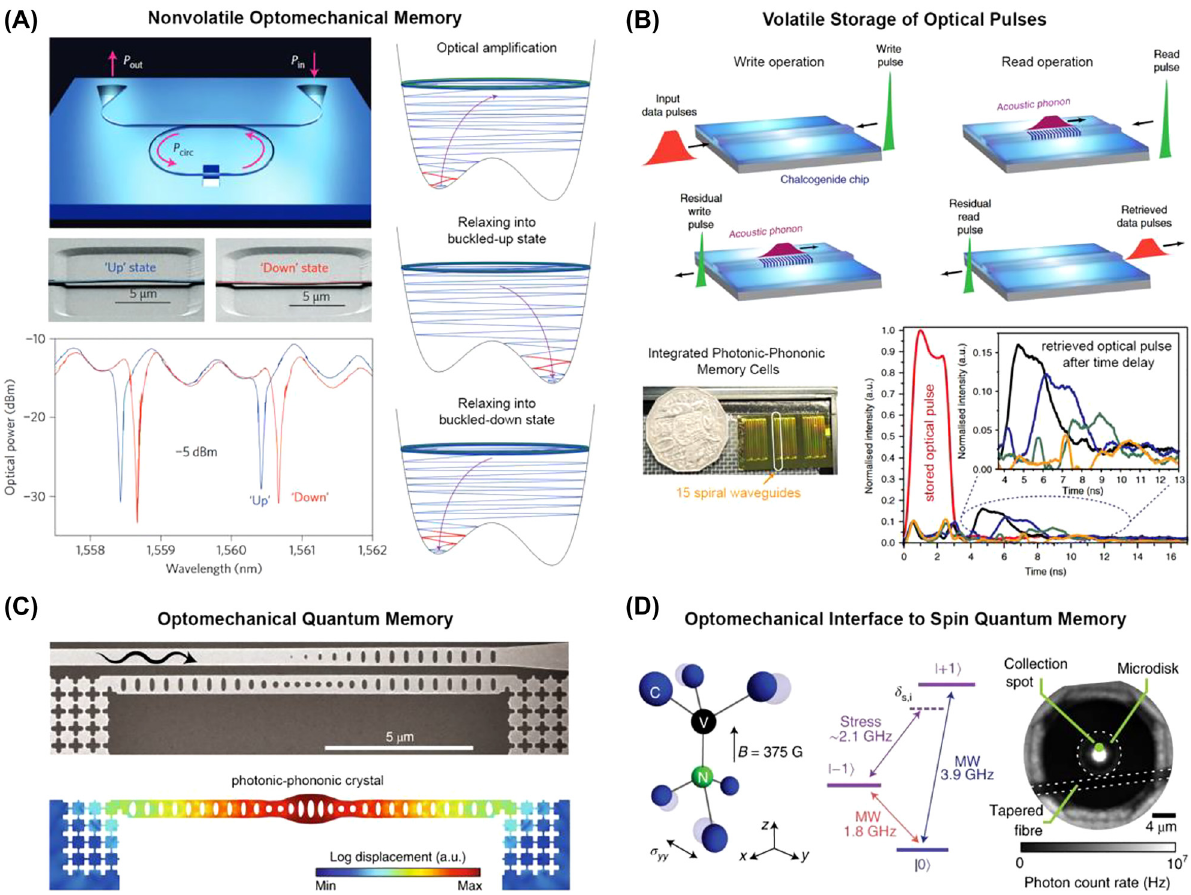
Figure 11: Optomechanical methods for all-optical storage of classical and quantum information. (A) Demonstration of nonvolatile optical memory using a partially suspended ring resonator exhibiting a mechanical bistability [125]. (B) Volatile storage of optical pulses using stimulated Brillouin scattering in chalcogenide spiral waveguides [122]. (C) SEM image and simulated mechanical displacement of an optomechanical quantum memory cell addressable at telecommunication wavelengths [128]. (D) Use of mechanical modes in a diamond microdisk resonator to manipulate spin quantum memory states